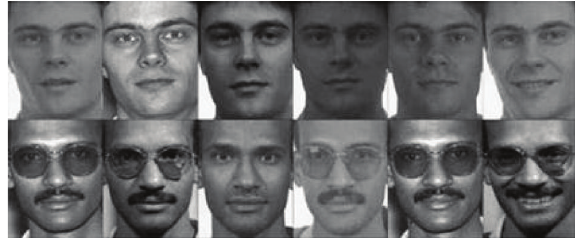
Figure 2: Images of two persons from FERET